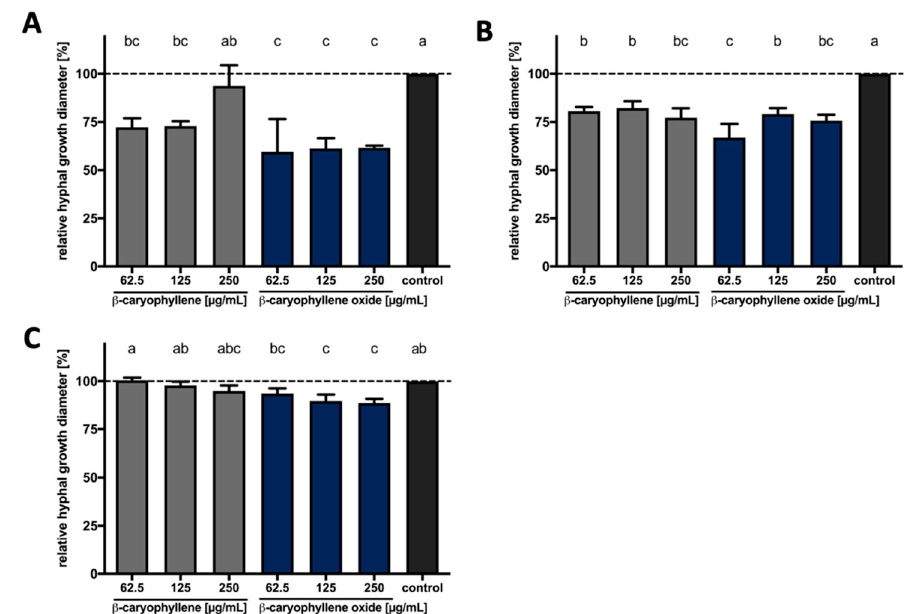
Figure 3. The effect of β -caryophyllene and β -caryophyllene oxide on the hyphal growth of plant pathogenic fungi. The effect of β -caryophyllene and β -caryophyllene oxide against S. sclerotiorum ( A ), F. oxysporum ( B ) and A. brassicicola ( C ). Final concentrations of 62.5 µ g mL − 1 , 125 µ g mL − 1 , and 250 µ g mL − 1 of β -caryophyllene (grey bars) and β -caryophyllene oxide (blue bars) in PDA growth medium were used. Medium mixed with the solvents DMSO and Tween 20 (final concentrations, 0.5% and 1% v / v , respectively) was used as the control (black bars). An equally sized disk with fungal mycelium was placed in the center of each plate and incubated for seven days at 24 °C. Subsequently, the diameter of each fungal colony was measured, and the relative growth compared to the solvent control was calculated. Each bar represents the mean ± standard deviation of three independent biological measurements with three technical replicates each ( n = 9). Different letters on the top of the bars indicate significant differences between the treatments based on ANOVA and Holm-Sidak post-hoc method ( p < 0.05), while the same letters represent no significant differences.